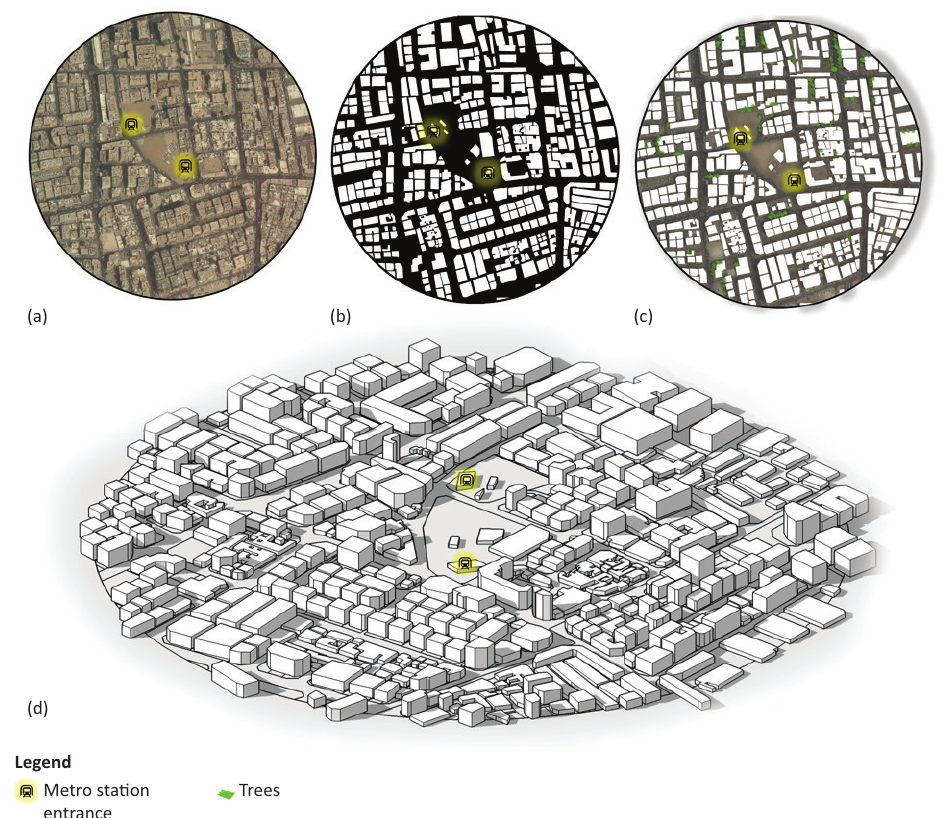
Figure 5. The surroundings of the metro station: (a) Buildings within a 400 m radius of Al Mansoura metro station, (b) built form coverage, (c) existing (and very minimal) greenery, and (d) building forms.